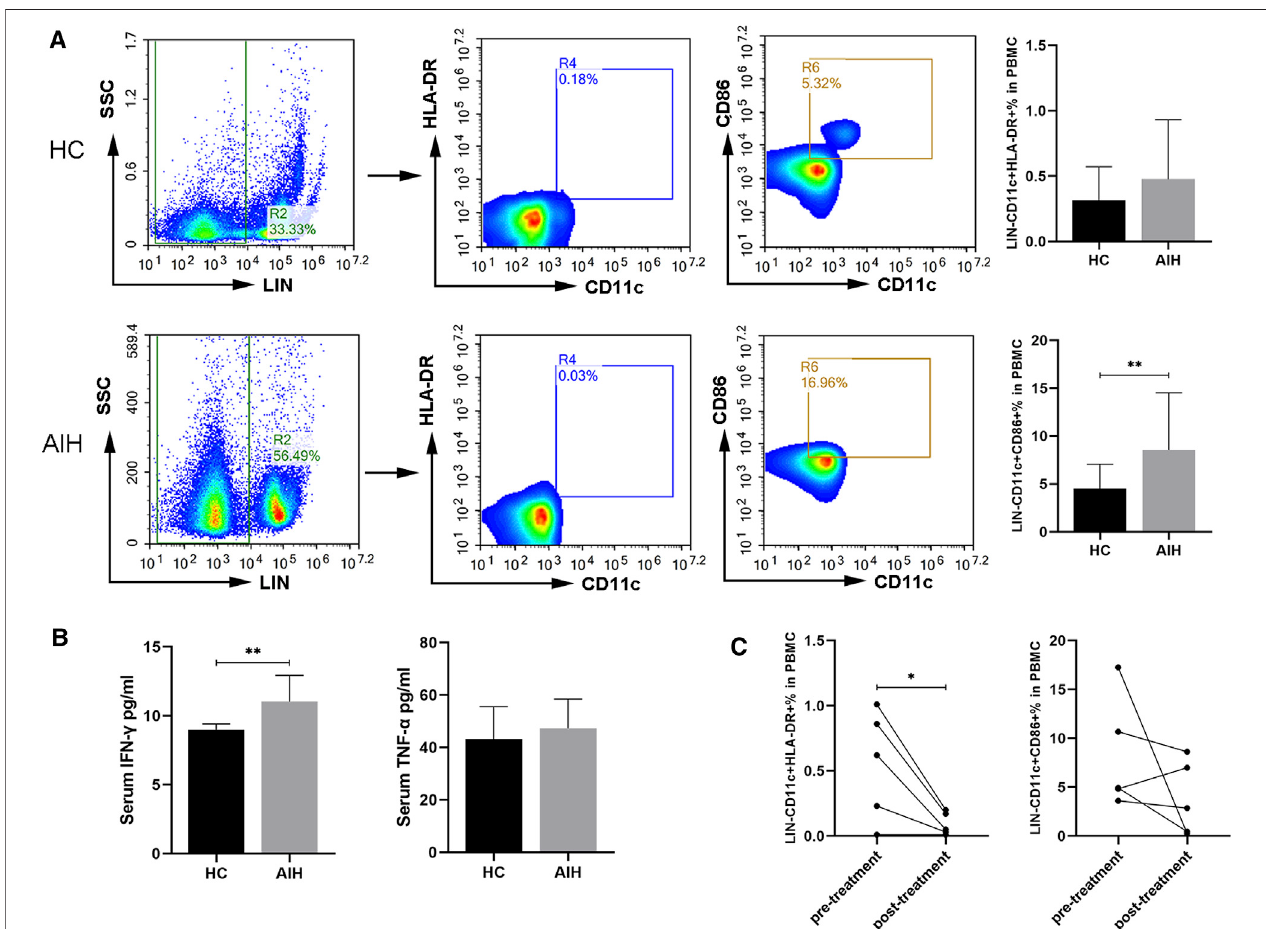
FIGURE 1 | Circulating mature DCs and cytokines in the peripheral blood compared between HCs and AIH patients. (A) Flow cytometric analysis of the percentages of CD11c + CD86 + and CD11c + HLA-DR + DCs between HCs and AIH patients. (B) Serum cytokines related to DC maturation in the peripheral blood of HCs and AIH patients. (C) Changes in the proportions of CD11c + CD86 + and CD11c + HLA-DR + DCs from AIH patients before and after treatment. * p < 0.05 and ** p < 0.01.